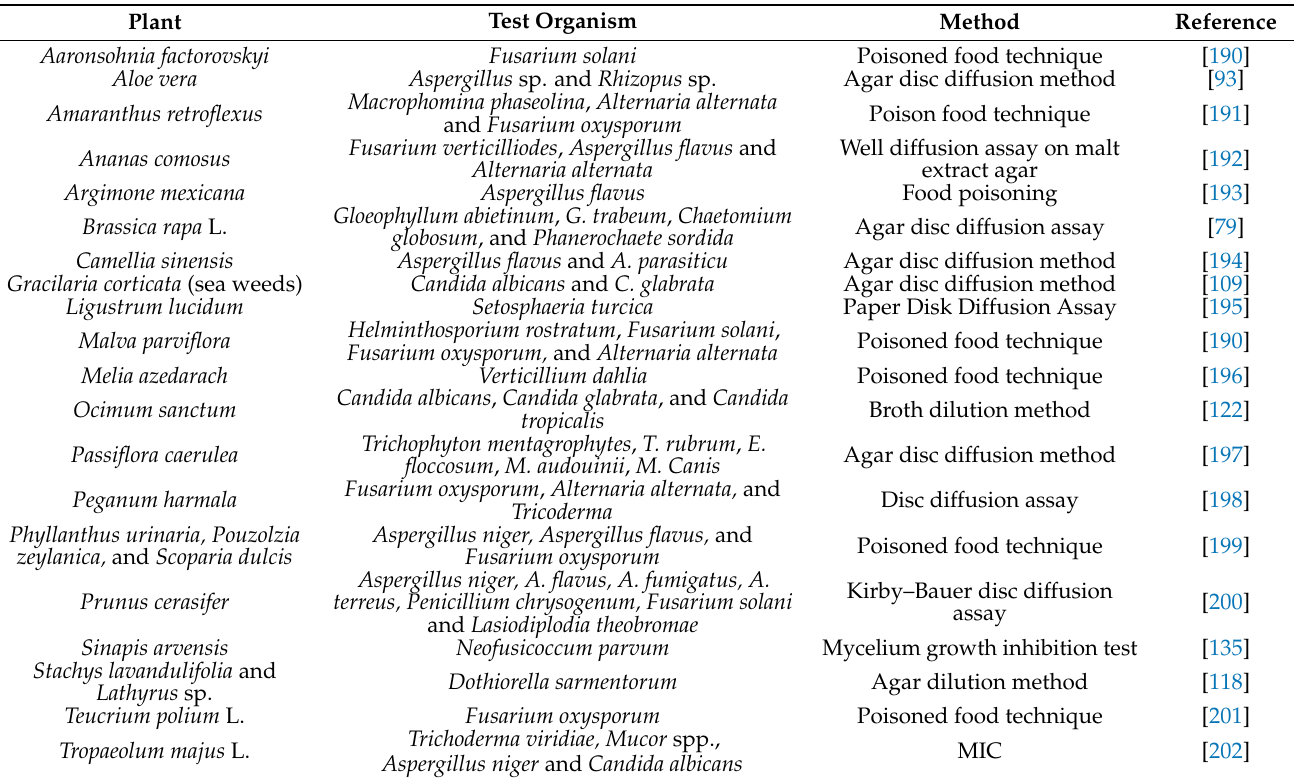
Table 3. Antifungal activity of biologically synthesized silver nanoparticles.